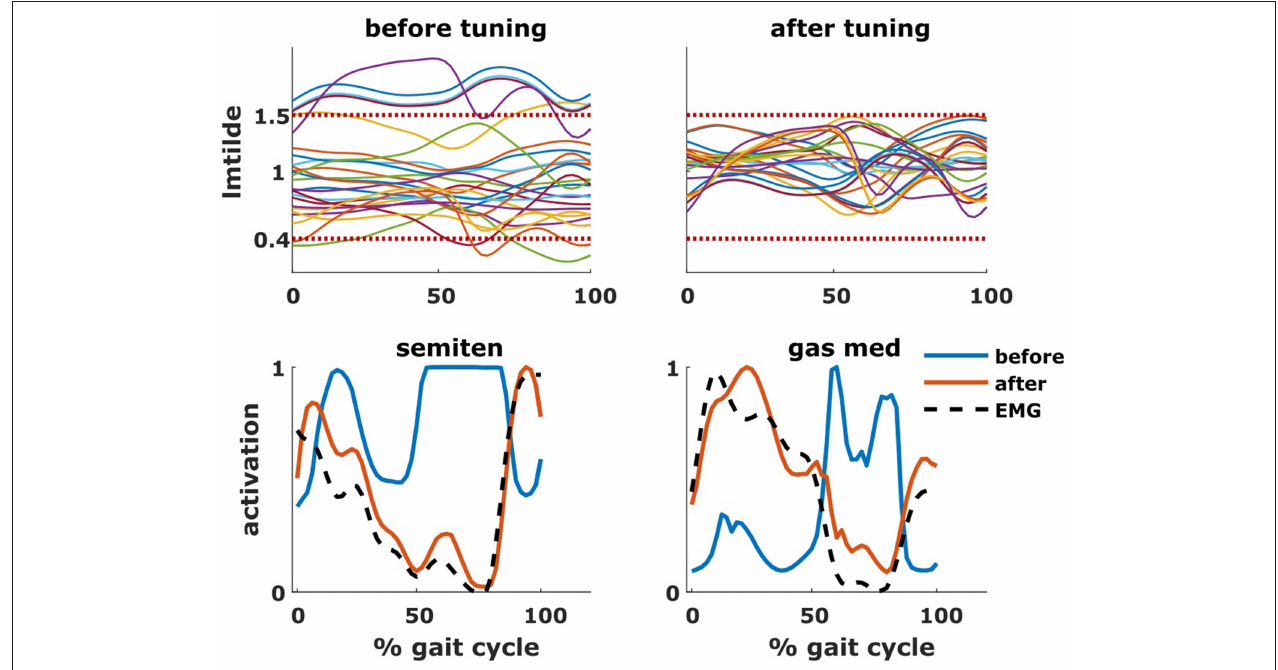
FIGURE 7 | Effect of tuning of muscle parameters. On the top row are plotted the values of the normalized muscle fiber lengths of all the tuned muscles throughout the gait cycle. The two horizontal dotted lines represent the constraints imposed during the optimization process. On the bottom row are plotted the activations of two representative muscles (semitendinosus and gastrocnemius medialis), before and after the optimization, as well as the experimental EMG